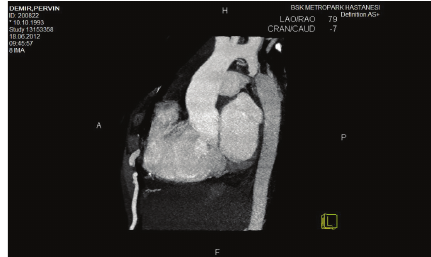
Figure 1: Sinus of Valsalva aneurysm, coarctation of aorta, and dilated internal thoracic artery in CT